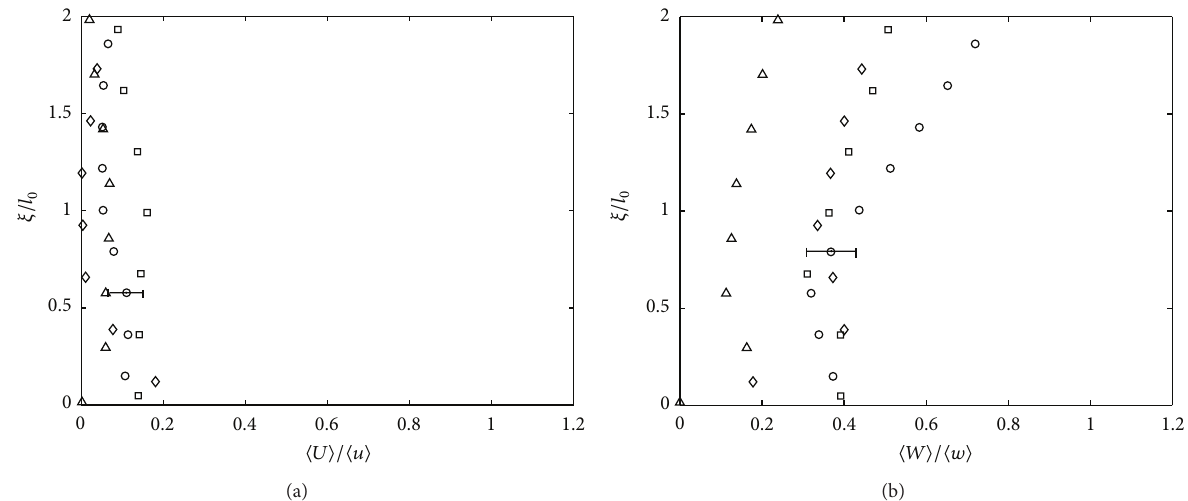
Figure 2: Plots (a) and (b) show the turbulence intensities ⟨𝑈⟩/⟨𝑢⟩ and ⟨𝑊⟩/⟨𝑤⟩ against dimensionless height 𝜉/𝑙 0 . The four experiments shown correspond to 𝑅𝑒 𝑙 = 570 ( ∘ ), 𝑅𝑒 𝑙 = 325 ( ◻ ), 𝑅𝑒 𝑙 = 209 ( 󳵻 ), and 𝑅𝑒 𝑙 = 117 ( ⬦ ). To avoid saturation, a single error bar has been included in each plot which is representative of the variability observed in all of the data